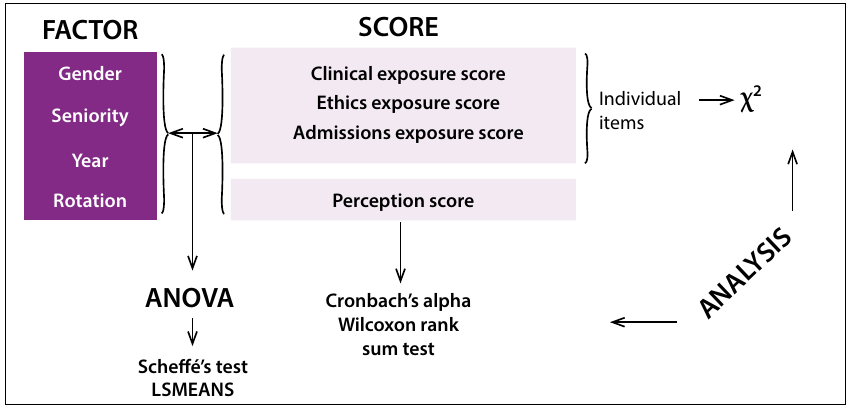
Fig. 1. Data analysis scheme. (Statistical significance at p